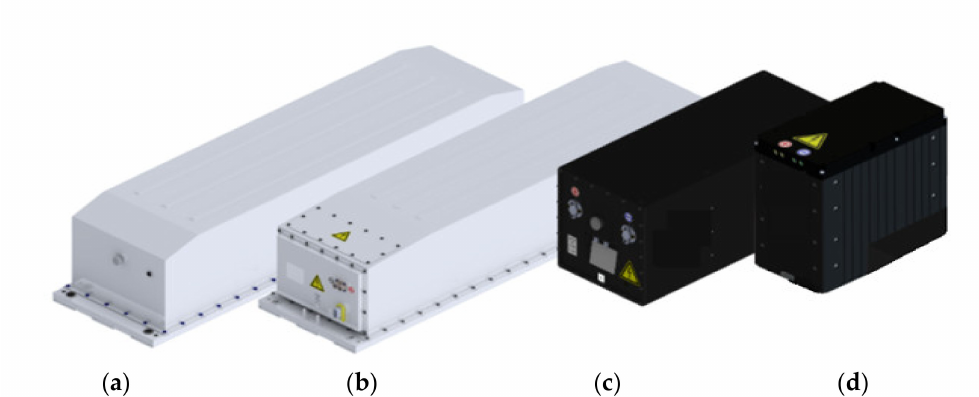
Figure 9. ( a ) NMC-b/Pouch type/280 kg/32 × 44 × 170 cm/bottom of the pack: steel/perimeter of the pack: aluminum/1 pack, ( b ) LTO/Prismatic type/260 kg/32 × 44 × 170 cm/bottom of the pack: steel/perimeter of the pack: aluminum/1 pack, ( c ) NMC-c/Pouch type/80 kg/27 × 28 × 70 cm/base of the module: plastic/perimeter of the module: aluminum/1 module, ( d ) NMC-a/Pouch type/ 28 kg/30 × 18 × 33 cm/base of the module: plastic/perimeter of the module: aluminum/1 module. The batteries in Figure 10, specified as (a) NCA/cylindrical type/13 kg/25 × 37 × 18 cm/plastic package and (b) LFP/cylindrical type/20 kg/32 × 25 × 21 cm./plastic package LIBs were also used in Exp. A experiments.